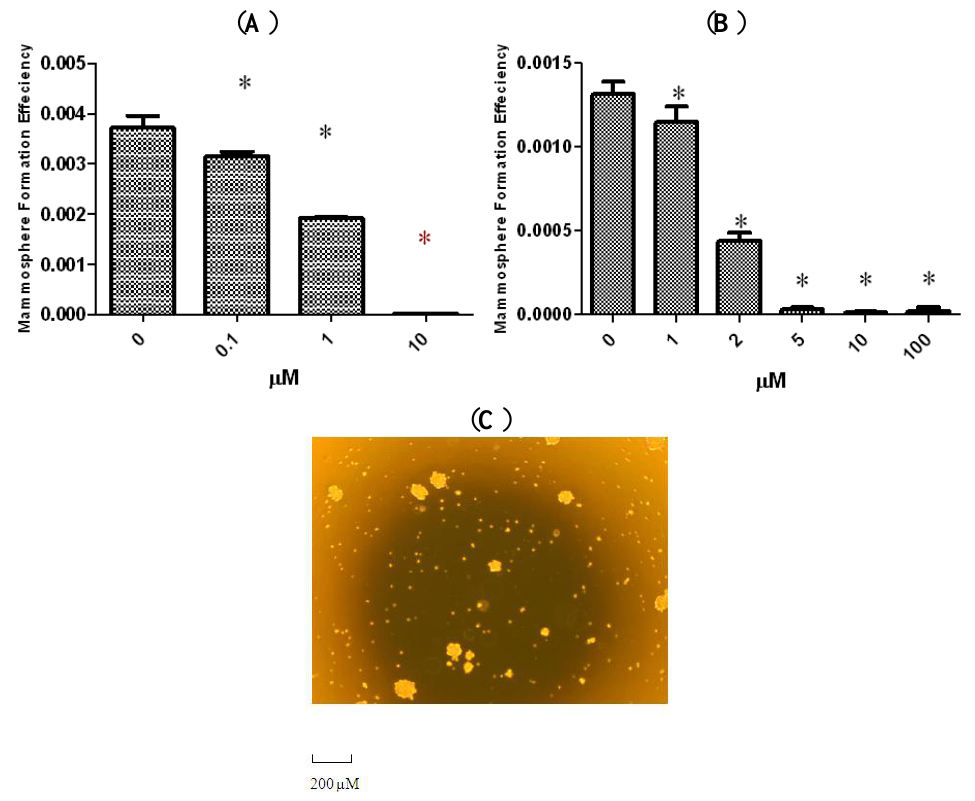
Figure 2. Inhibitory effect of Tetrandrine on mammosphere formation. SUM-149 ( A ) and SUM-159 ( B ) cells were cultured in mammosphere-forming conditions. SUM-149 and SUM-159 cells were incubated with indicated dose of tetrandrine or DMSO in mammosphere formation media for 7 days. Tetrandrine treatment reduced the number of primary mammospheres in a dose dependent manner; ( C ) Representative image of mammospheres from SUM-159. Scale bar = 200 μM. The results are representative of three independent experiments; asterisks indicate P < 0.05 compared to control in all cases. Error bars represent standard deviation.